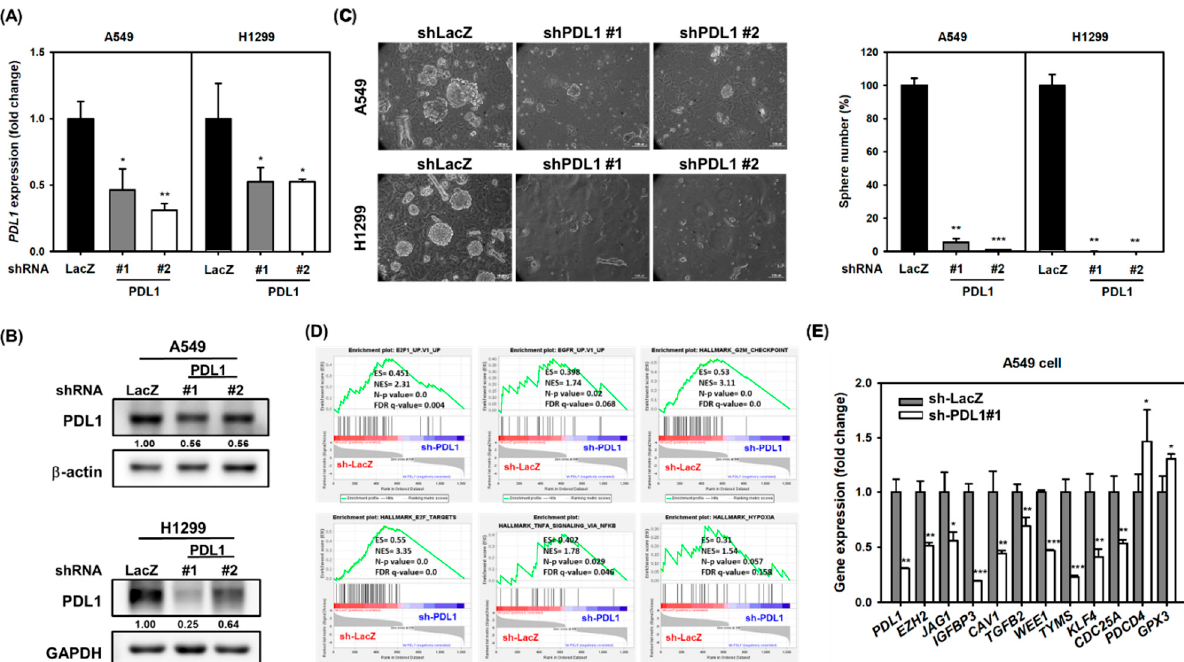
Figure 5. Knockdown of PD-L1 inhibits CSC activity in NSCLC cells. ( A–C ) The knockdown of PD-L1 in A549 or H1299 cells was performed by lentiviral delivery of PD-L1-specific shRNAs (shPDL1#1 or shPDL1#2). The mRNA ( A ) or protein expression ( B ) of PD-L1 were determined by qRT-PCR or Western blot analysis, respectively. The inserted numbers in ( B ) indicated the relative expression levels in comparison to sh-LacZ group after normalization to GAPDH. * p < 0.05; ** p < 0.01. The CSC activity was determined by tumorsphere cultivation ( C ). The inserted scale bars indicate 100 μ m in length. Data were presented as relative percentages of the tumorsphere number of the shLacZ group. ** p < 0.01; *** p < 0.001. ( D ) The GSEA analysis of RNA sequencing data from shLacZ or shPDL1#1 lentivirus transduced A549 cells was performed by GSEA software. ES, enrichment score; NES, normalized enrichment score; n - p value, nominal p value; FDR q -value, false discovery rate q -value. ( E ) The mRNA expressions of selected genes in A549 after transduction of shLacZ or shPDL1#1 lentiviruses were determined by real-time RT-PCR. Data were presented as relative expression levels to the shLacZ group. * p < 0.05; ** p < 0.01; *** p < 0.001.